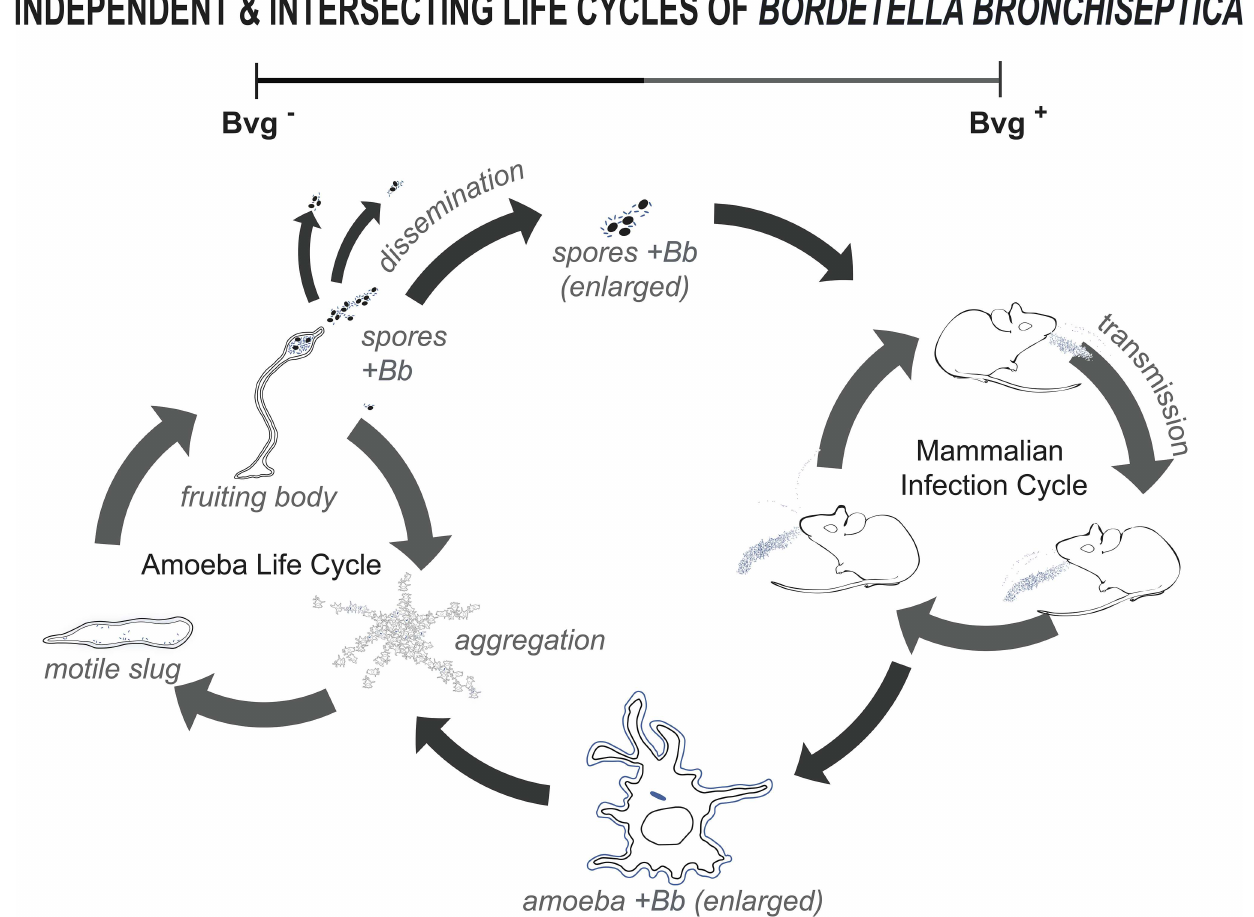
Fig 12. Model illustrating how BvgAS may regulate two independent but interconnected life cyclesof B . bronchiseptica . The model illustrates the survival and transmission of B . bronchiseptica (blue) both in the mammalian host (in Bvg + phase)and along with the amoeba (in Bvg - phase) and the connections betweenthese cycles. Infected mice shed B . bronchiseptica , which can both transmit to colonizeother mammalian hosts and spread in the environment. The Bvg + phasegenes are known to be necessaryfor B . bronchiseptica colonization and transmission betweenmammalianhosts. Outside the mammalianhost, in the Bvg- phase, B . bronchiseptica can form a stable associationwith the amoebae, like D . discoideum , such that it is incorporatedinto the fruiting body sori and transmitted from sorus to sorus. This association may constitute an alternative life cycle for bordetellae, involvingthe many Bvg - specific genes that are highly conservedyet not apparently expressedduringthe mammalian infectioncycle. Importantly, B . bronchiseptica recovered from amoebasori can efficiently infect mice, indicating that these two independent life cycles are interlinked. Bb , B . bronchiseptica